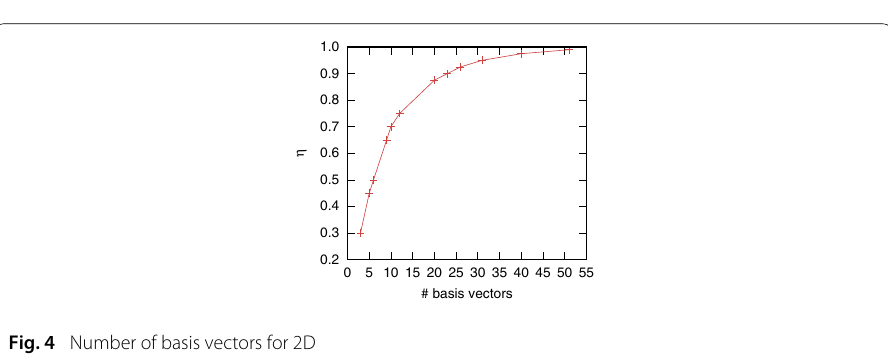
Fig. 4 Number of basis vectors for